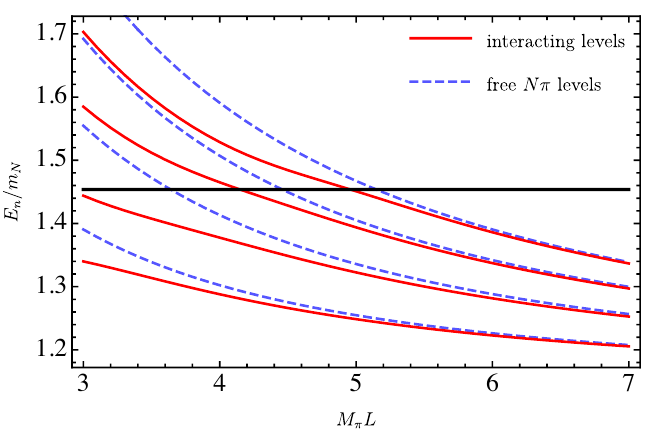
Figure 3 . Energy levels for different box sizes L considering only pion and nucleon as intermediate states. The red solid lines display the numerical results for the interacting energy levels and the blue dashed lines the free (non-interacting) energy levels of the pion and nucleon for | ~n (lowest to highest curve). The thick solid black line marks the mass of the Roper